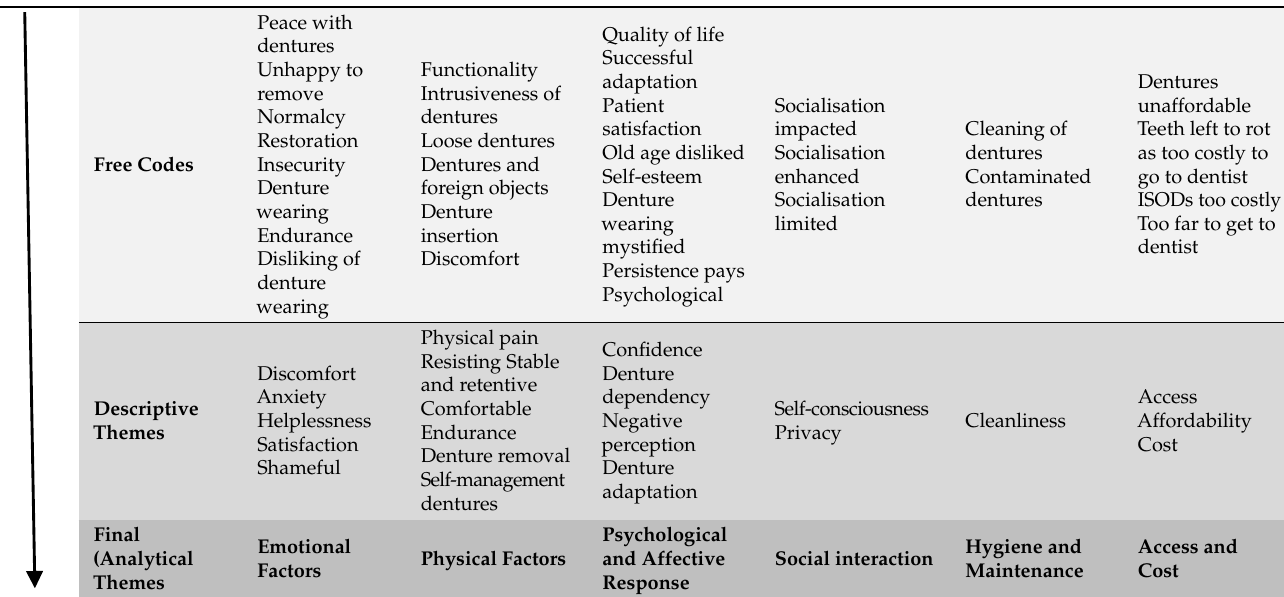
Table 3. Theme development flow diagram.